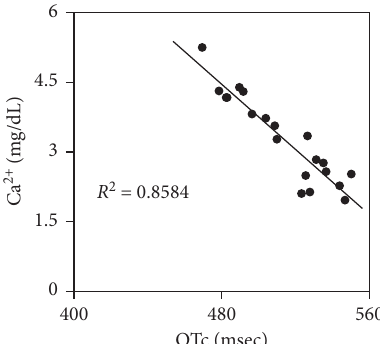
Figure 4: Correlation between Ca 2+ and QTc interval. R 2 indicates coefficient of